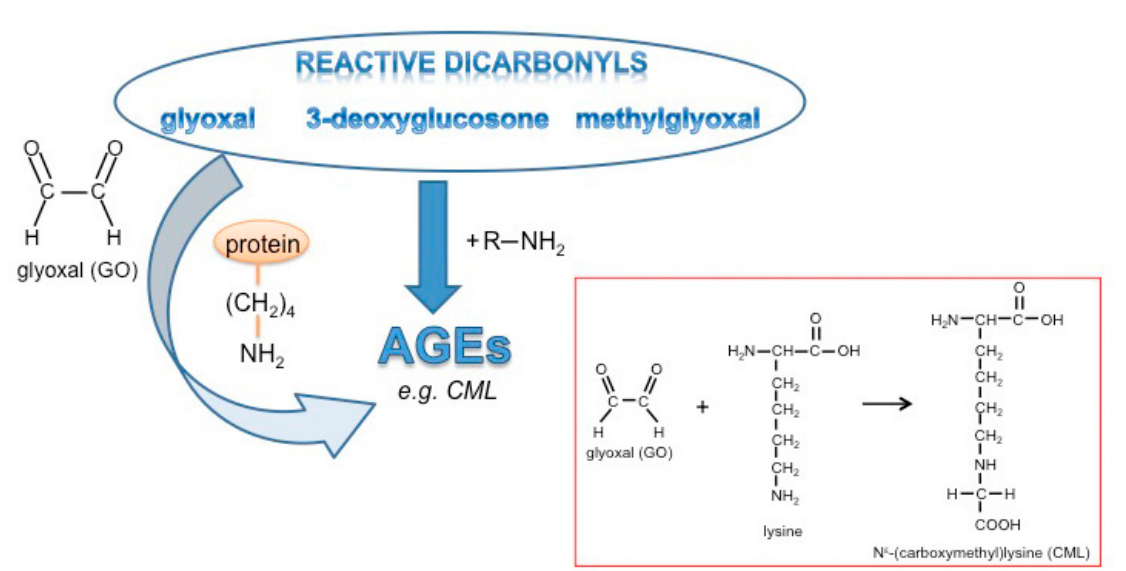
Figure 2. Glycation of conditioned media (CM) with GO. ( A ) Control CM and Wnt3a CM were treated with different concentrations (0, 1, 2 mM) of GO for 5 h and analyzed by SDS-PAGE and Western blotting with anti-CML26 antibody. ( B ) After Western blot detection the same membrane was stained with Coomassie brilliant blue to show equal loading. The strong band corresponds to bovine serum